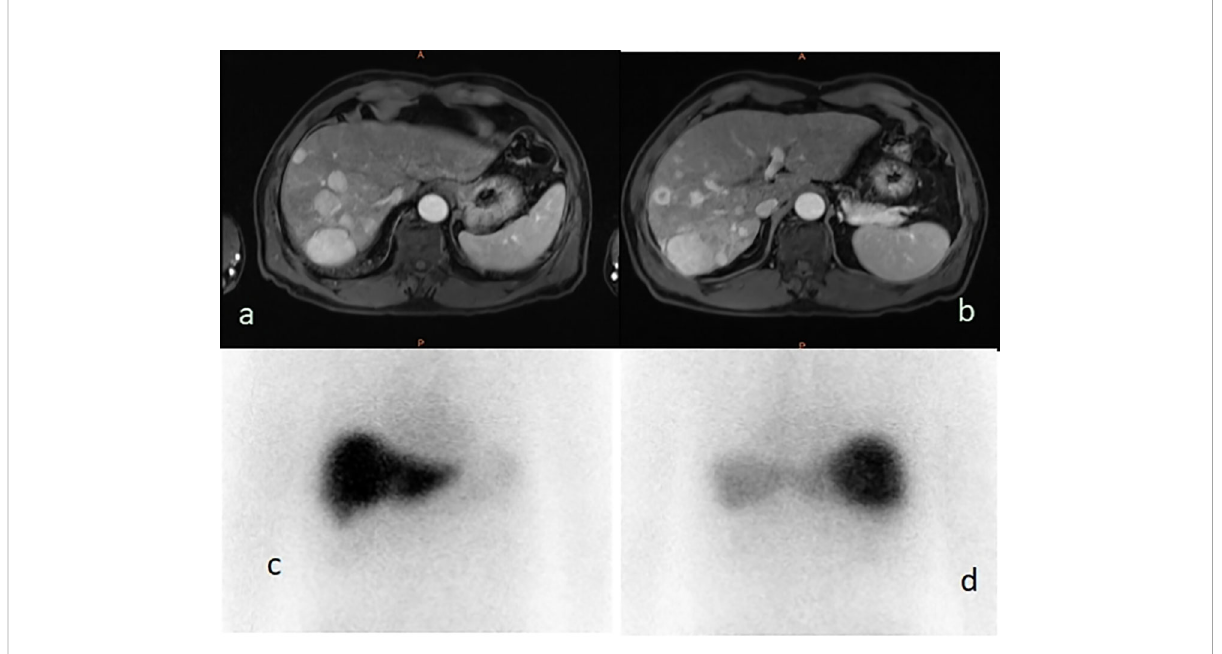
FIGURE 2 (A, B) The liver magnetic resonance imaging demonstrated multiple parenchymal nodules in right lobe of liver (5.0 × 3.8 cm 2 ); (C) The 131-I whole body scan showed that the right and left lobes of the liver were evenly uptake of 131-I before, and the multiple nodules showed no higher uptake than the surrounding liver tissues; (D) The 131-I whole body scan showed that the right lobe of the liver was evenly uptake of 131- I, and the multiple nodules showed no higher uptake than the surrounding liver